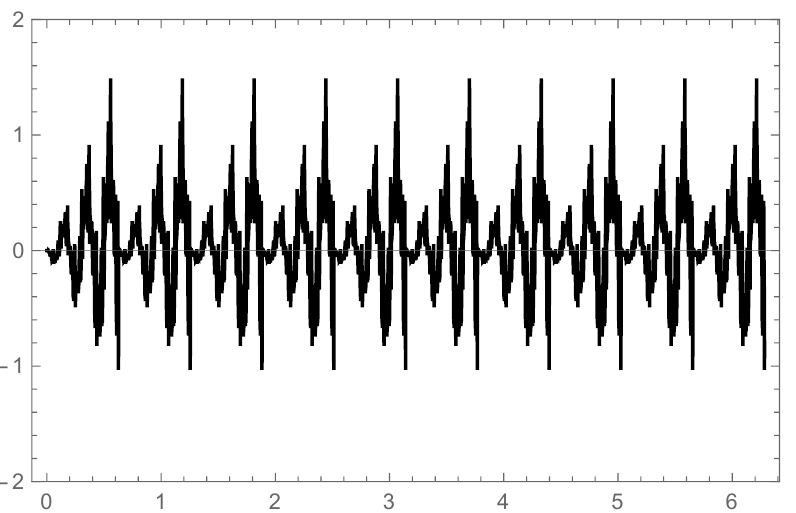
Figure 1. Graph of the image of the function b ( x ) = sin ( π x ) by the operator L 0 in the interval I = [ 0,2 π ] (fractal convolution of the null function with a